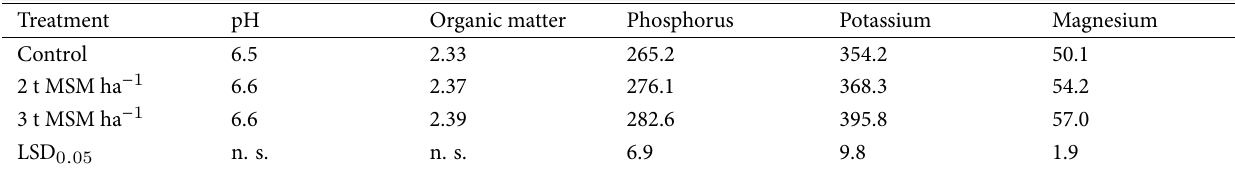
Table 6 Soil pH (1 M KCl), content of organic matter (%), and content of available phosphorus, potassium, and magnesium (in mg kg − 1 soil ) relative to MSM